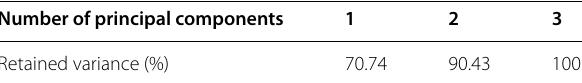
Table 3 Retained variance in dimension reduction process Number of principal components 1 2 Retained variance (%)